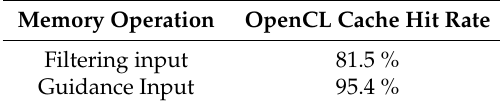
Table 6. Cache hit rates in the OpenCL generated cache.